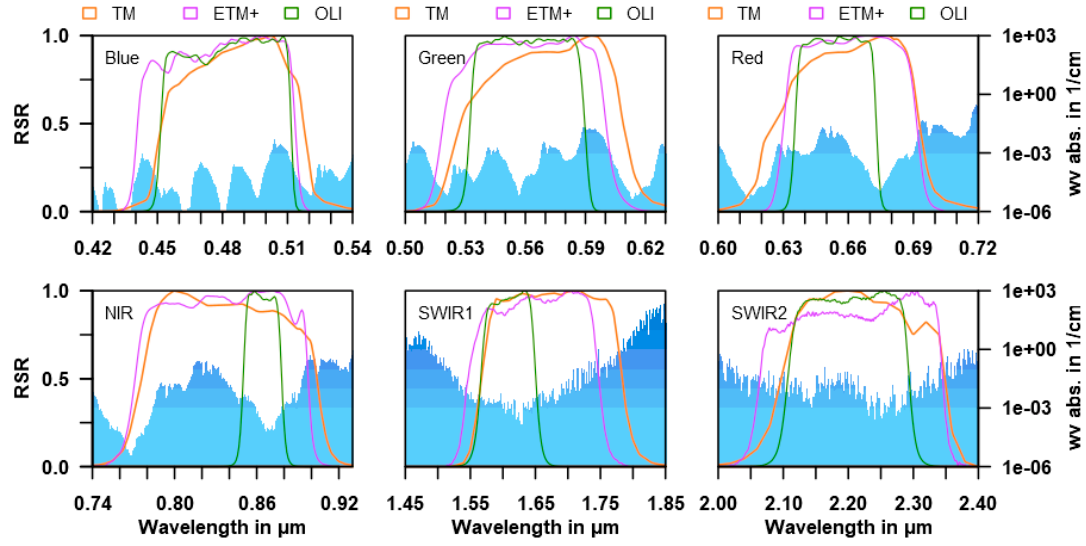
Figure 7. Band-wise Relative Spectral Response (RSR) per sensor (colored lines) and water vapor absorption coefficients (blue polygon). The water vapor absorption coefficients are plotted with logarithmic scale and color bar.